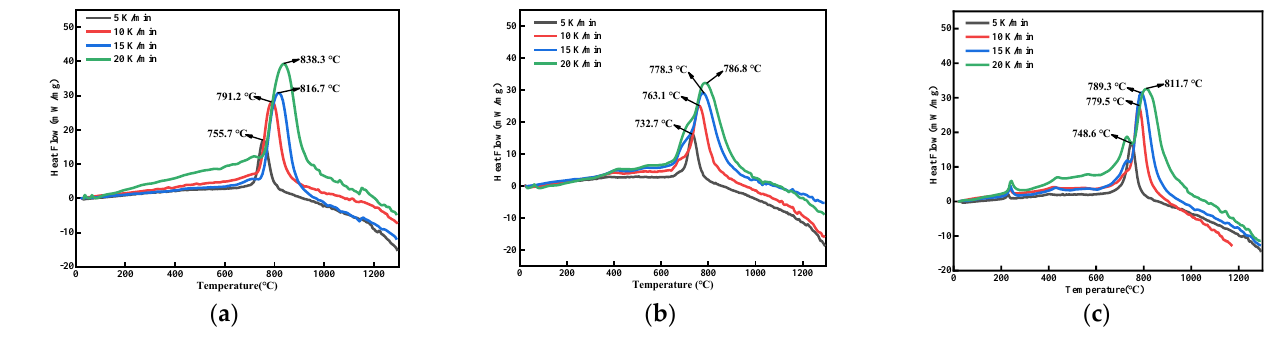
Figure 8. DSC curves of n-B ( a ), nB@F2603 ( b ), and nB@F2603@CL-20 ( c ) at different heating rates. Table 1. Peak temperatures and kinetic parameters of samples.